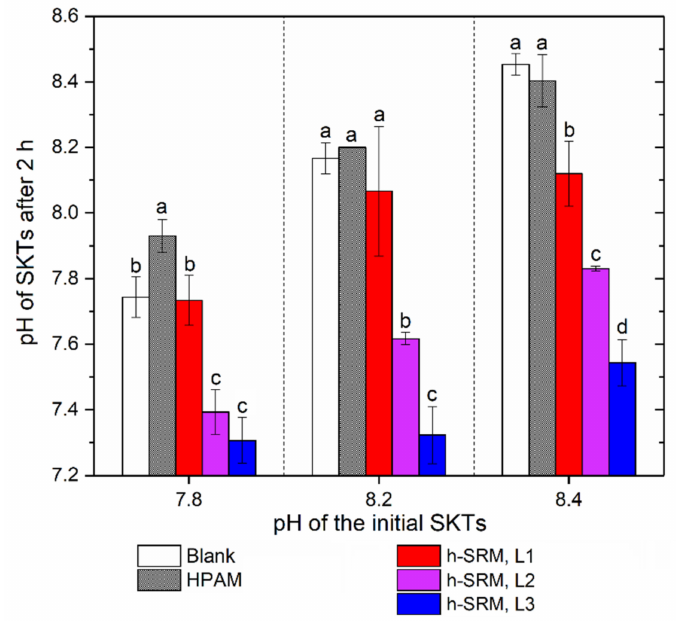
Figure 5. Supernatant pH of SKTs at 2 h of tailings settling. SRM-peptides are labelled as h-SRM, added at three dosage levels (L1–L3) from 10 kg to up to 30 kg per ton of kaolinite solids. The semi-bar represents the standard deviation of each experimental triplicate. Within a given pH group, bars that are annotated with the same letter ( a – d ) are statistically similar at a 95% confidence